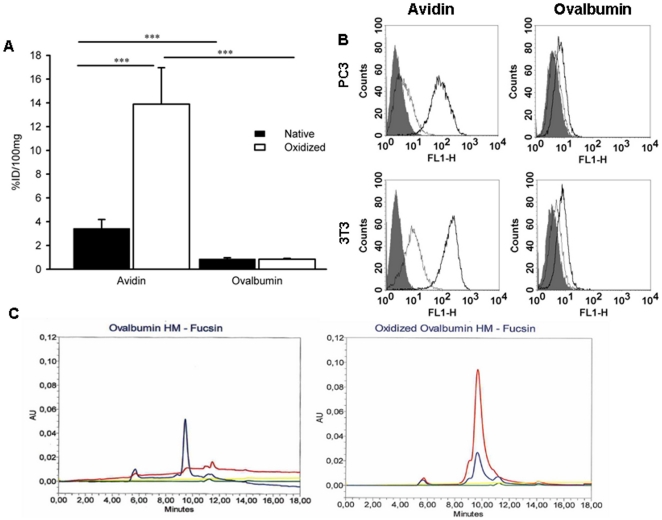
Tissue residence and in vitro cell binding of native and oxidized avidin and ovalbumin.
A, Avidin and ovalbumin were 125I-labeled and then oxidized with sodium periodate. After purification, native and oxidized samples were diluted at 3.0 mg/ml in sodium acetate pH 5.5 and 15 µl were injected intramuscularly in one hind limb of mice. After 24 hours, the mice were sacrificed and treated limbs collected, weighed and counted in a gamma counter. Data are expressed as the % of injected dose/100 mg (% ID/100 mg) of tissue. Each point is the average of 5 mice. Bars represent standard deviation. Statistical analysis by Student's t test. ***p<0.001. B, Cytofluorimetry of the binding of native and oxidized avidin and ovalbumin to human prostate carcinoma PC3 and mouse fibroblast NIH-3T3 cells. Cells were incubated with 150 µM of either native or oxidized avidin or ovalbumin and binding revealed by specific primary antibodies as detailed in Materials and Methods. Gray peaks represent background (second antibody, only). Thin and bold lines, native and oxidized glycoproteins, respectively. C, Size exclusion chromatography on Bio-Sep-SEC-S 3000 (Phenomenex) of ovalbumin (left panel) or oxidized ovalbumin (right panel) after reaction with pararosaniline dye (Schiff's reagent, Sigma-Aldrich, USA). Baseline absorbance of dye at 280 and 550 nm (yellow and green lines, respectively) and ovalbumin or oxidized ovalbumin absorbance peaks at 280 nm (blue) and 550 nm (red). Red peak in the right panel indicates the formation of Schiff's bases between oxidized ovalbumin and the pararosaniline dye thus confirming the presence of functional aldehydes on oxidized but not native (left panel) ovalbumin.